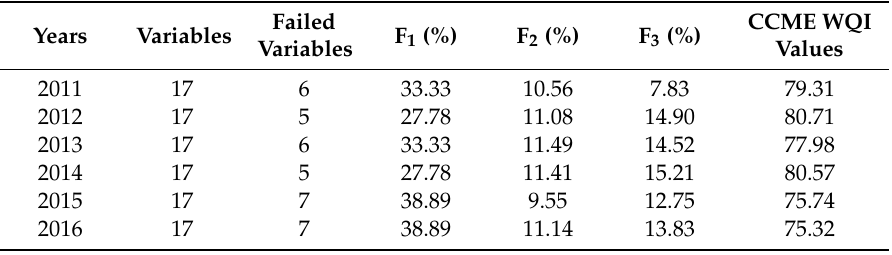
Table 3. Results of the Kruskal–Wallis (K–W) test.